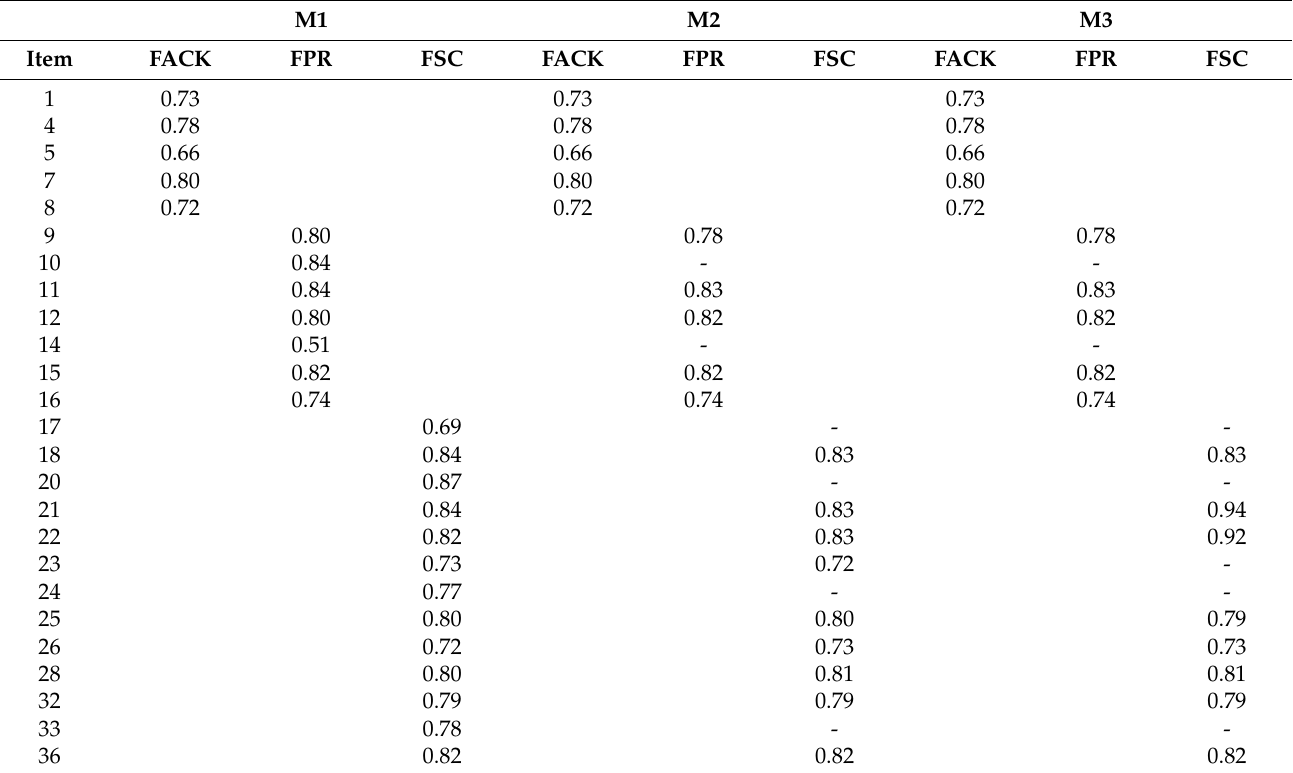
Table 3. Bayesian Confirmatory Factor Analysis posterior latent variables.